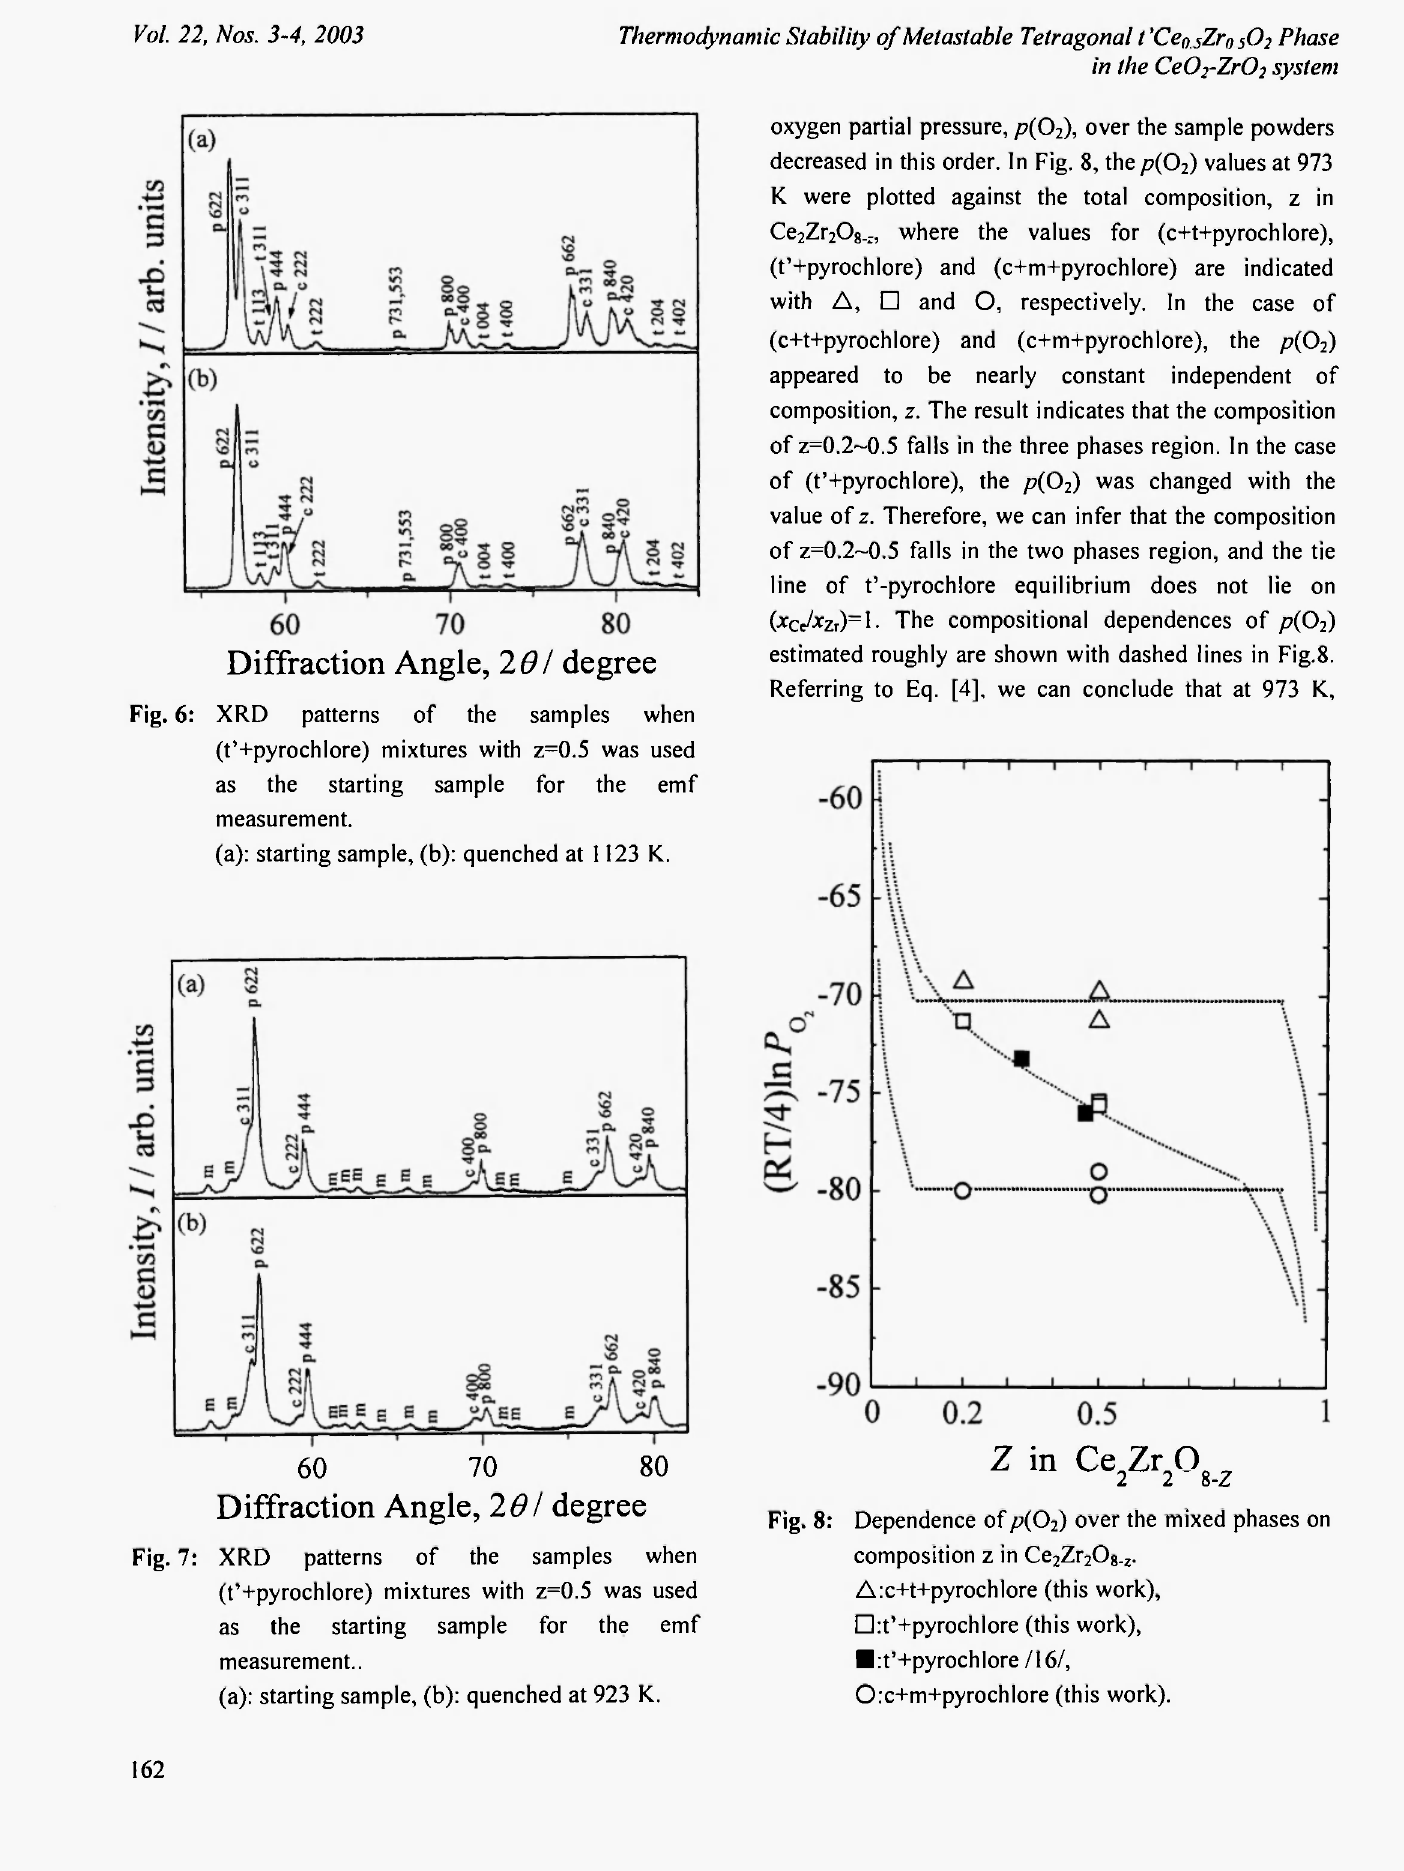
Fig. 7: XRD patterns of the samples when (t'+pyrochlore) mixtures with z=0.5 was used as the starting sample for the emf measurement.. (a): starting sample, (b): quenched at 923 K.